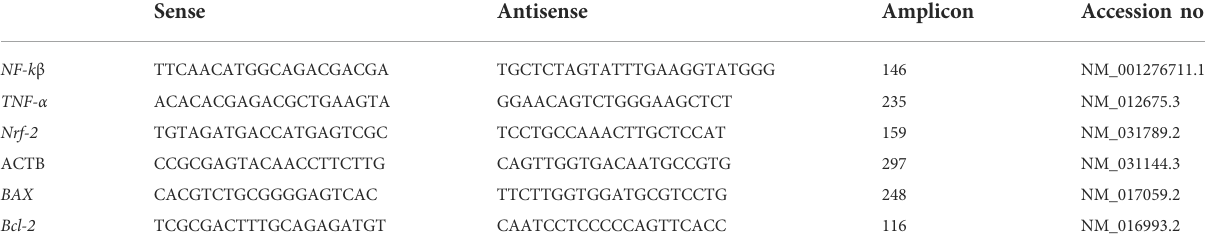
TABLE 1 The primer sets used in the